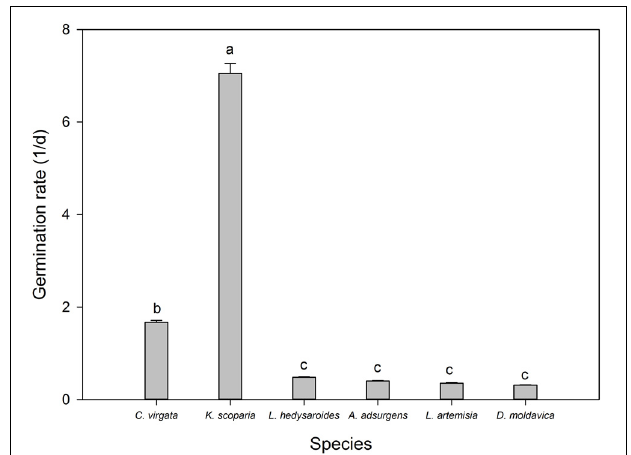
FIGURE 3 | Germination rate of the six species Kochia scoparia , Chloris virgata , Astragalus adsurgens , Lespedeza hedysaroides , Leonurus artemisia , and Dracocephalum moldavica . Rates with different lowercase letters differed significantly at 0.05